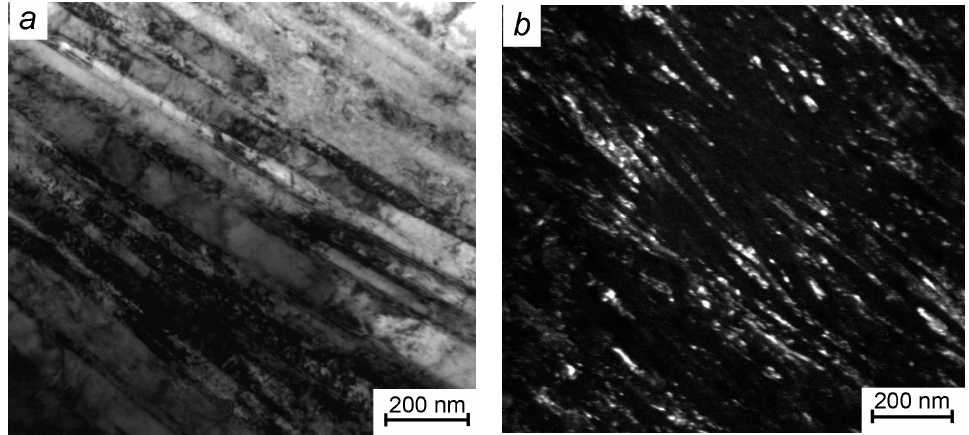
Figure 12. Planar microstructure of Cu-Nb nanolaminate subjected to HPT: N = 2, bright-field TEM image ( a ); N = 4, dark-field TEM image ( b